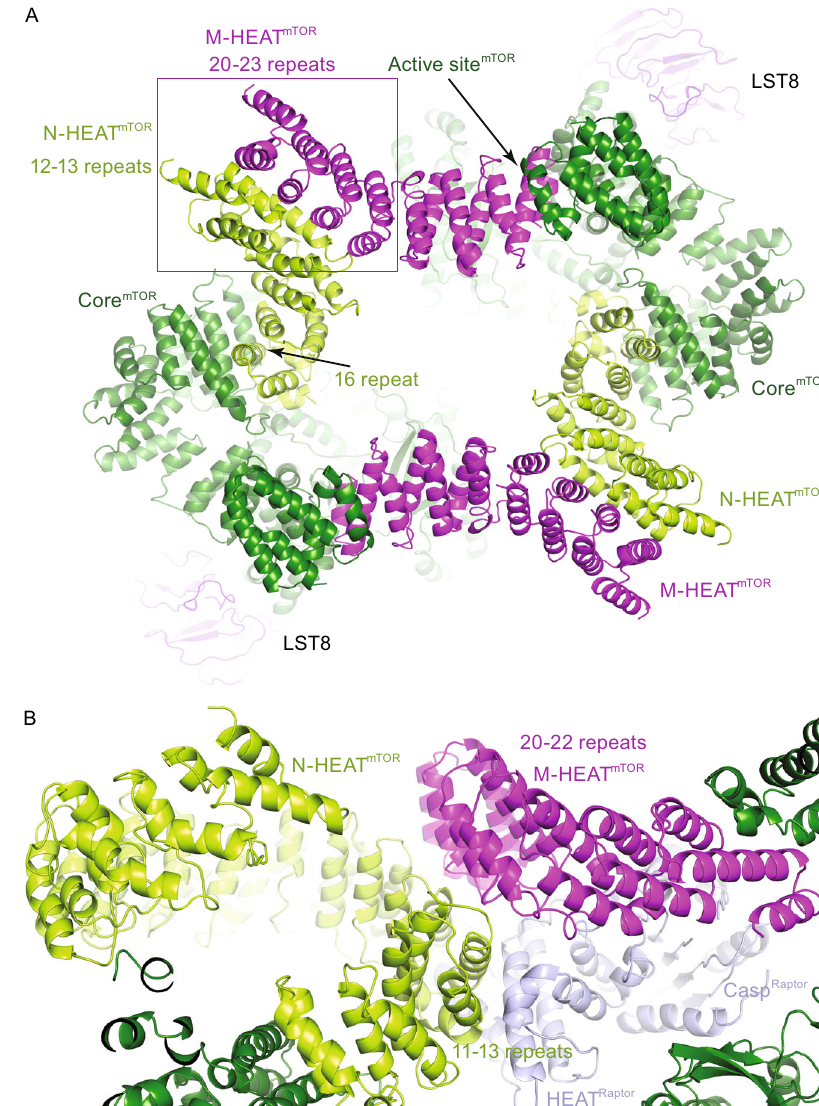
Figure 4. Intramolecular and intermolecular interactions within mTORC1. (A) Closed-up view of the dimer formation of mTORC1. Ribbon representation of the mTORC1 is shown. The mTORC1 dimer is formed through the intermolecular interaction between the M-HEATand the Core and that between the N-HEATand the Core. (B) Closed-up view of the interaction between Raptor and mTOR. Raptor binds to the ridge region of the M-HEAT repeats in one mTOR and the convex side of the N-HEAT region in the other